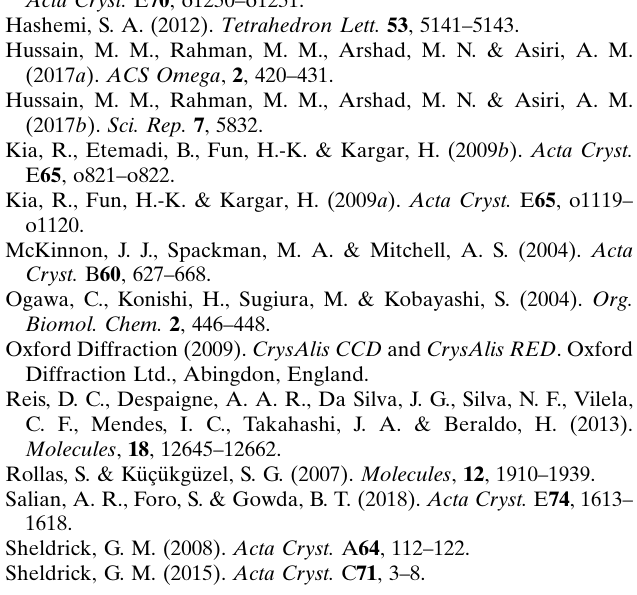
Oxford Diffraction Xcalibur diffractometer with Sapphire